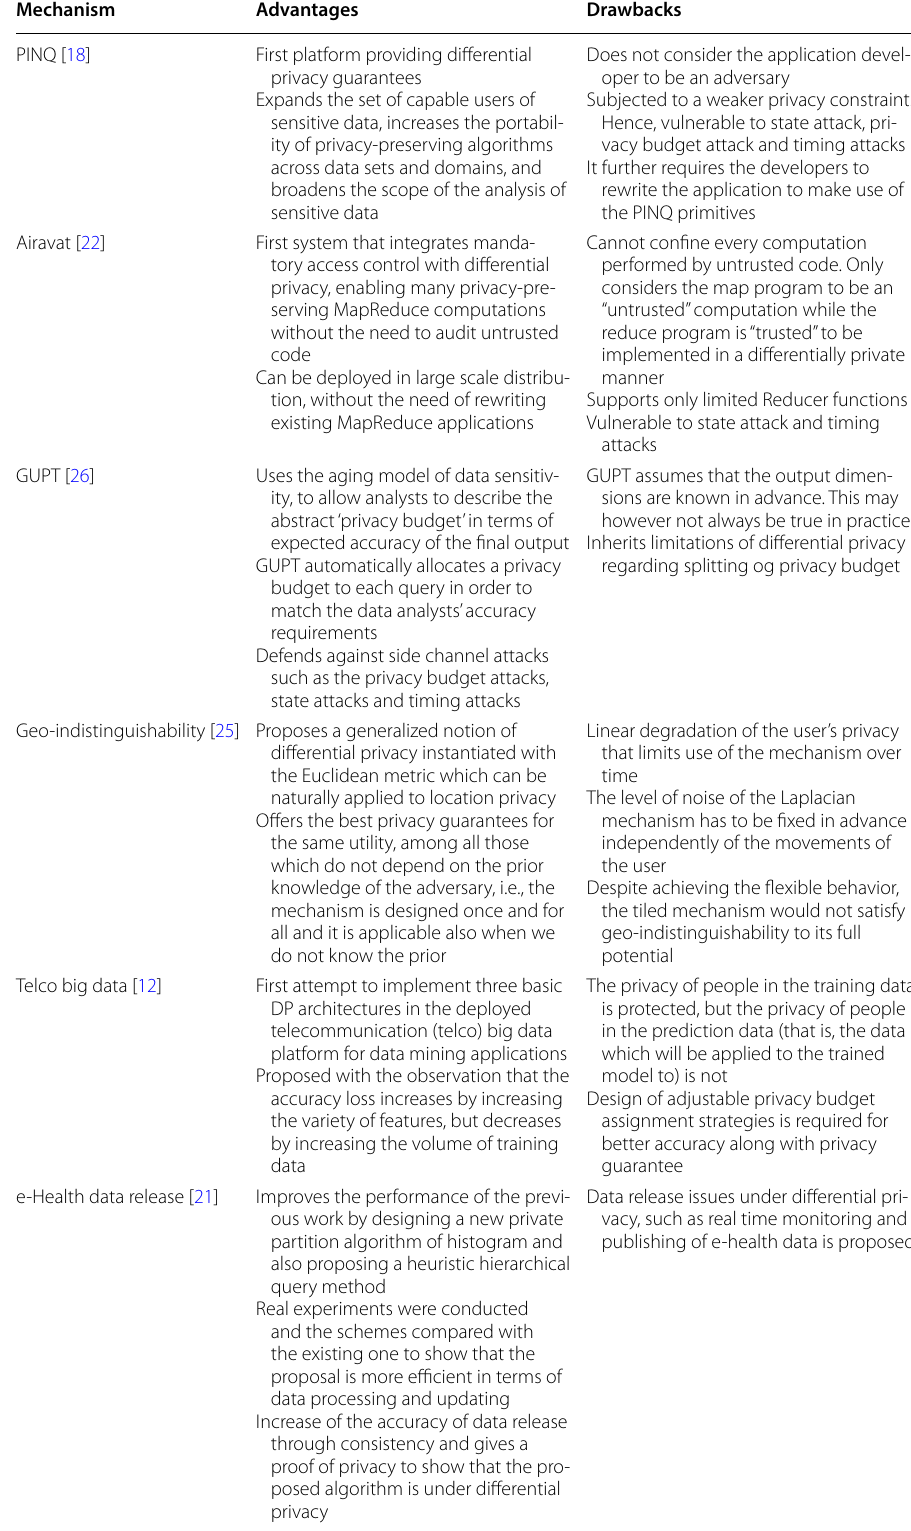
Table 3 Advantages and drawbacks of DP mechanisms